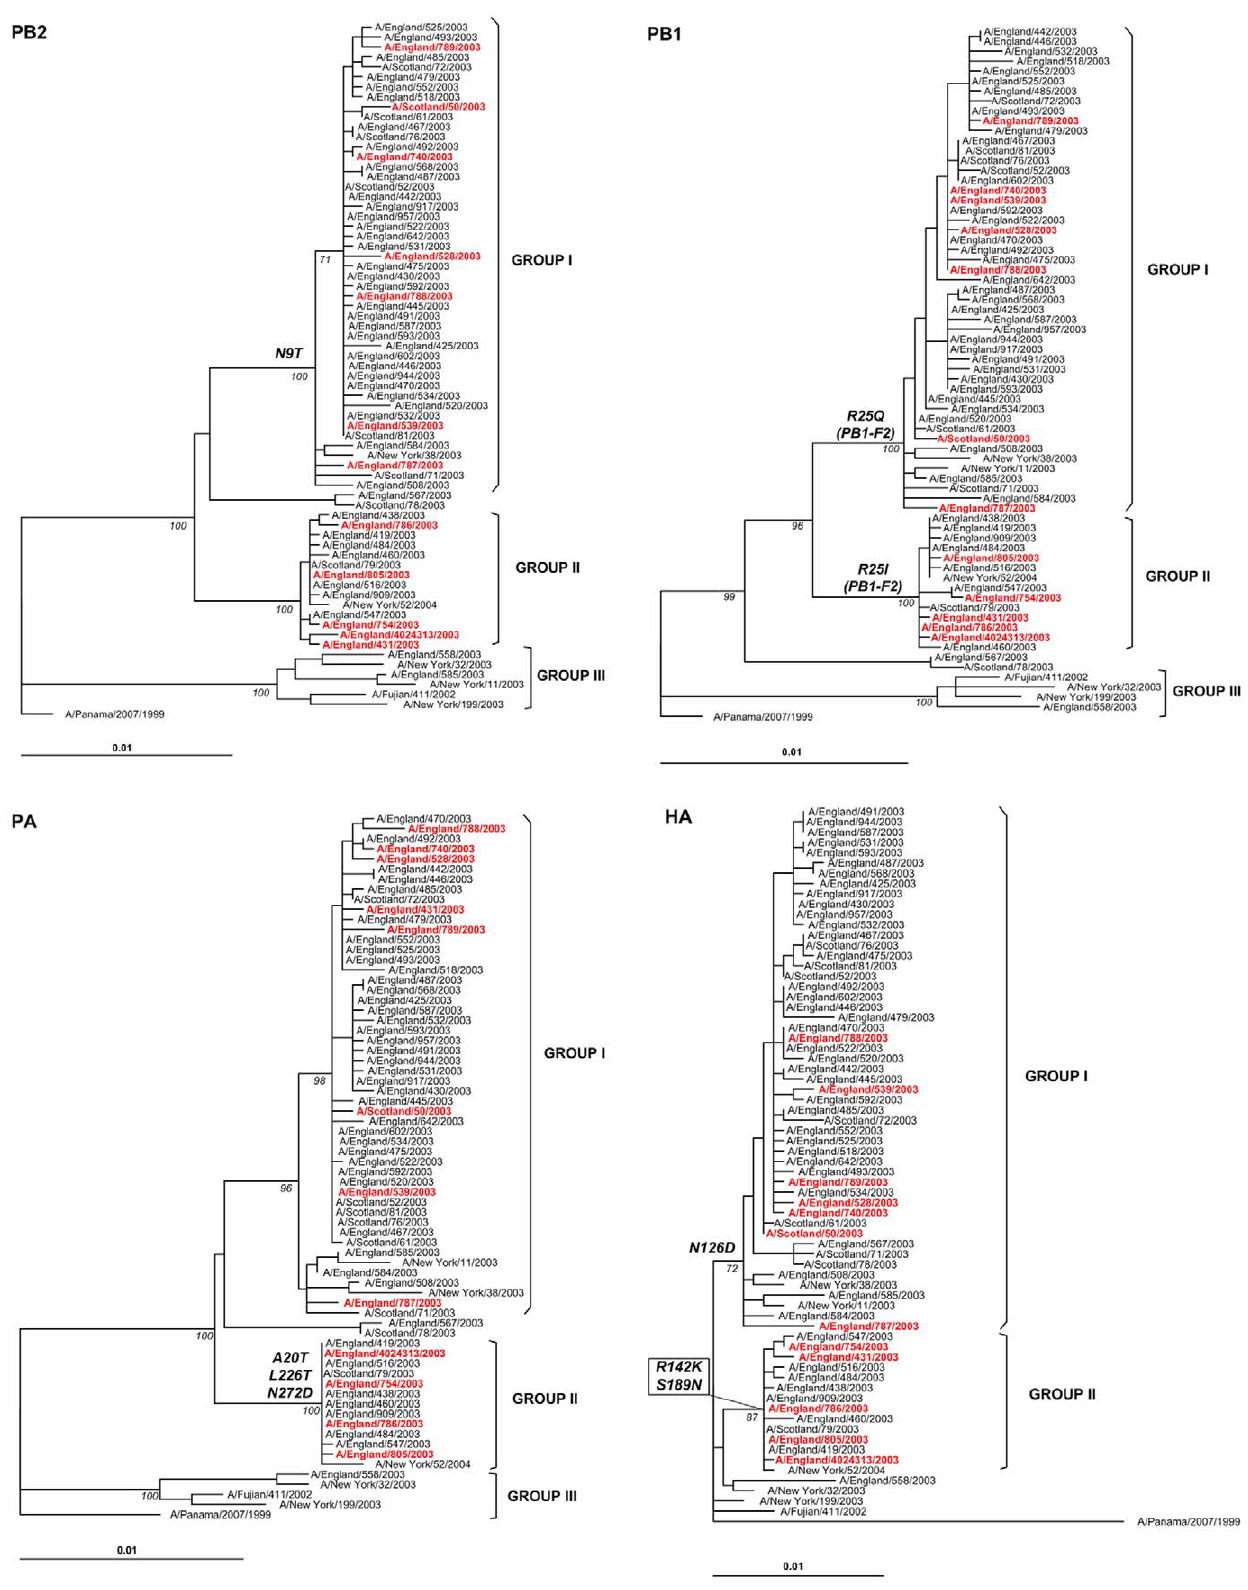
Figure 2. Phylogenetic relationships of the main coding regions of PB2, PB1, PA & HA of influenza A(H3N2) viruses isolated in the UK during 2003–2004. Details are similar to those described in Figure 1 footnote.